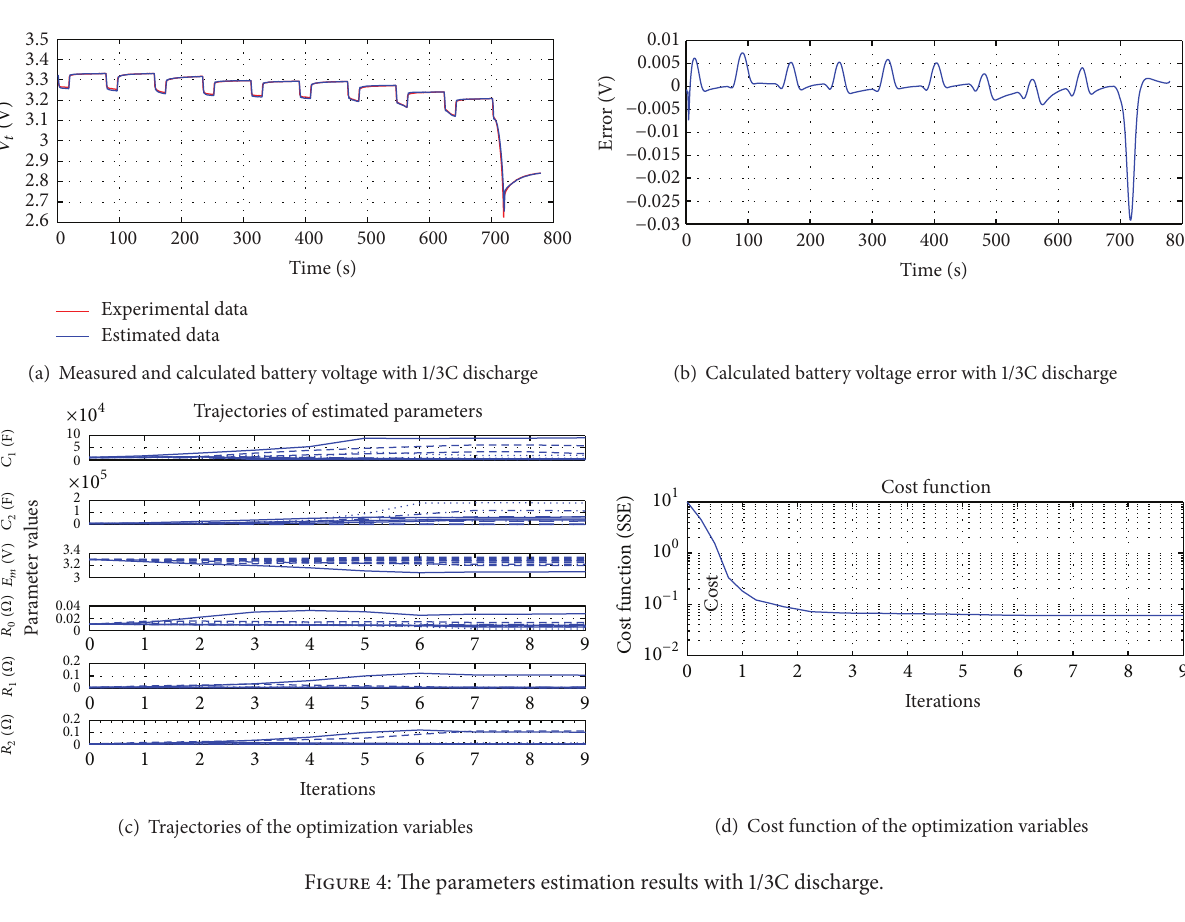
Figure 4: The parameters estimation results with 1/3C discharge.